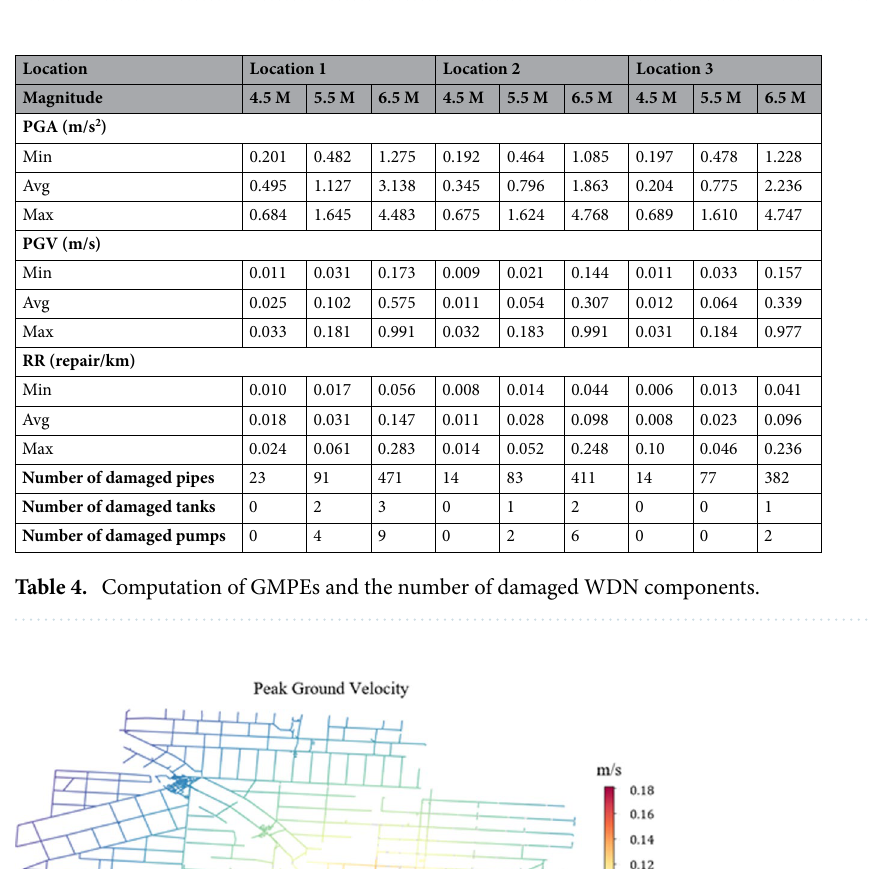
Figure 2. Studied WDN layout and earthquake scenarios configuration.